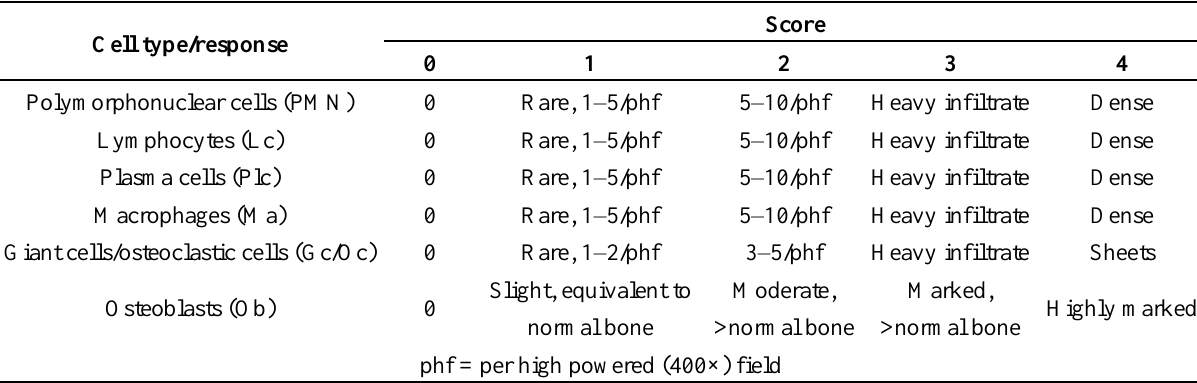
Table 2. Histopathologic scoring system (semi-quantitative).